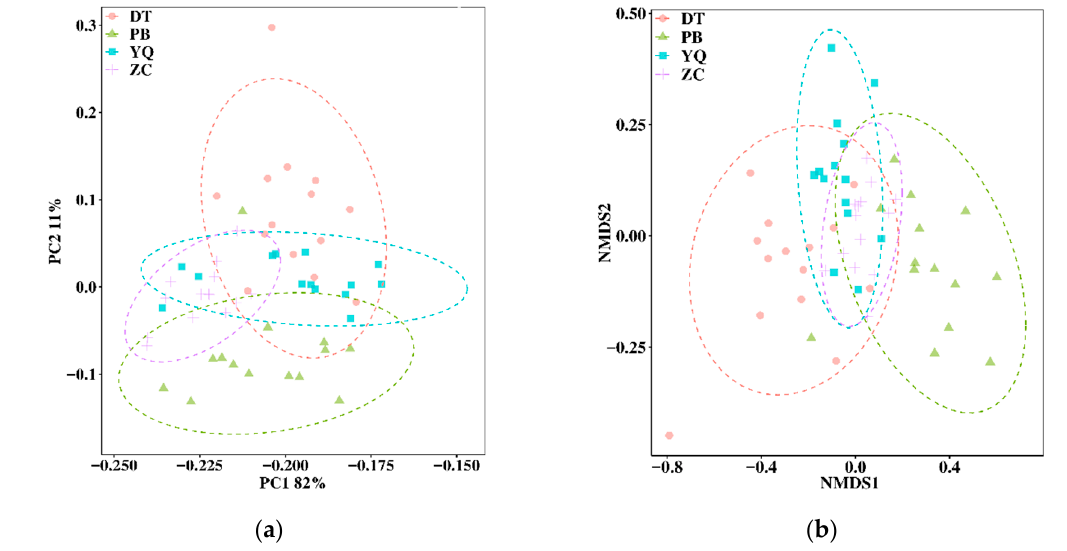
Figure 3. Principal component analysis (PCA; ( a )) and non-metric multidimensional scaling (NMDS; ( b )) analysis results of soil bacteria at the phylum level in mining areas.